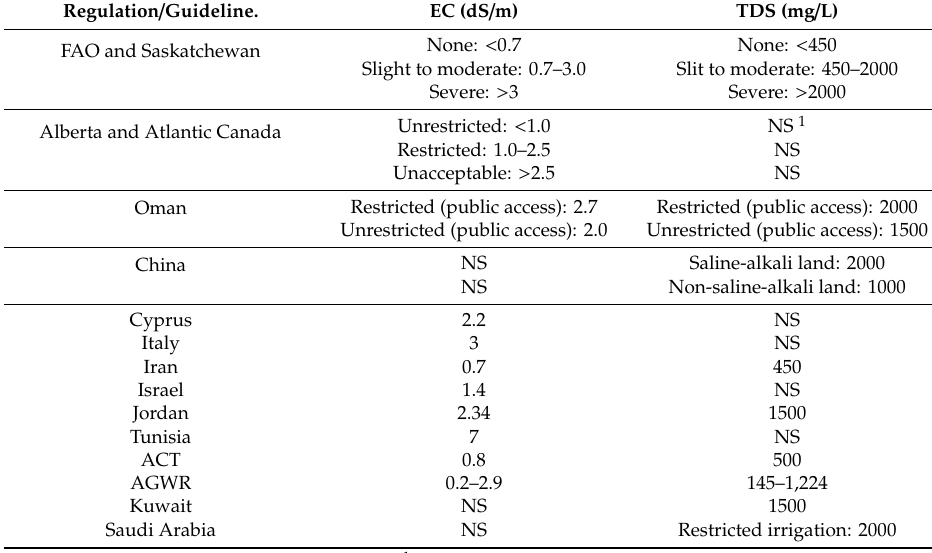
Table 9. Salinity (electric conductivity (EC) and total dissolved solids (TDS)) thresholds in agricultural water reuse regulations and